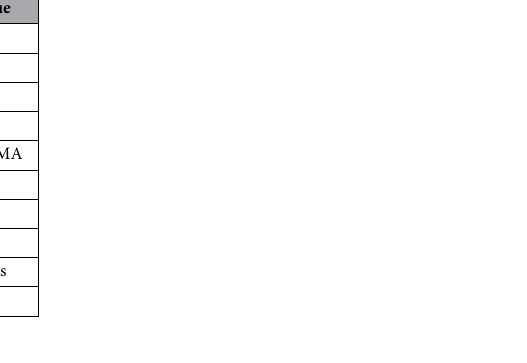
Table 1. Specifications of the ocular